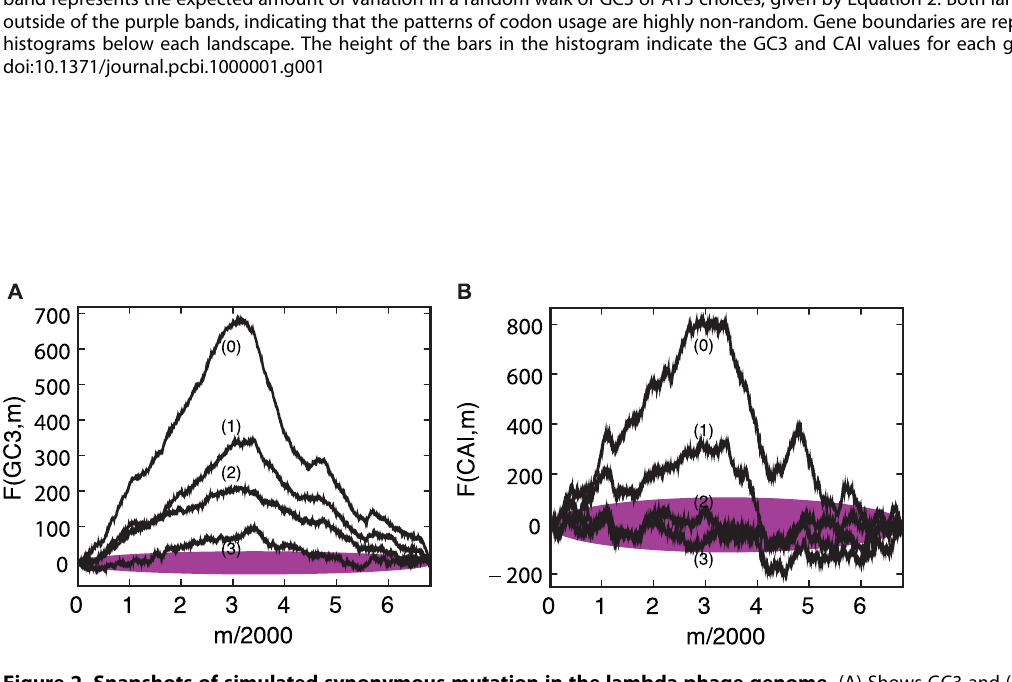
PLoS Computational Biology |